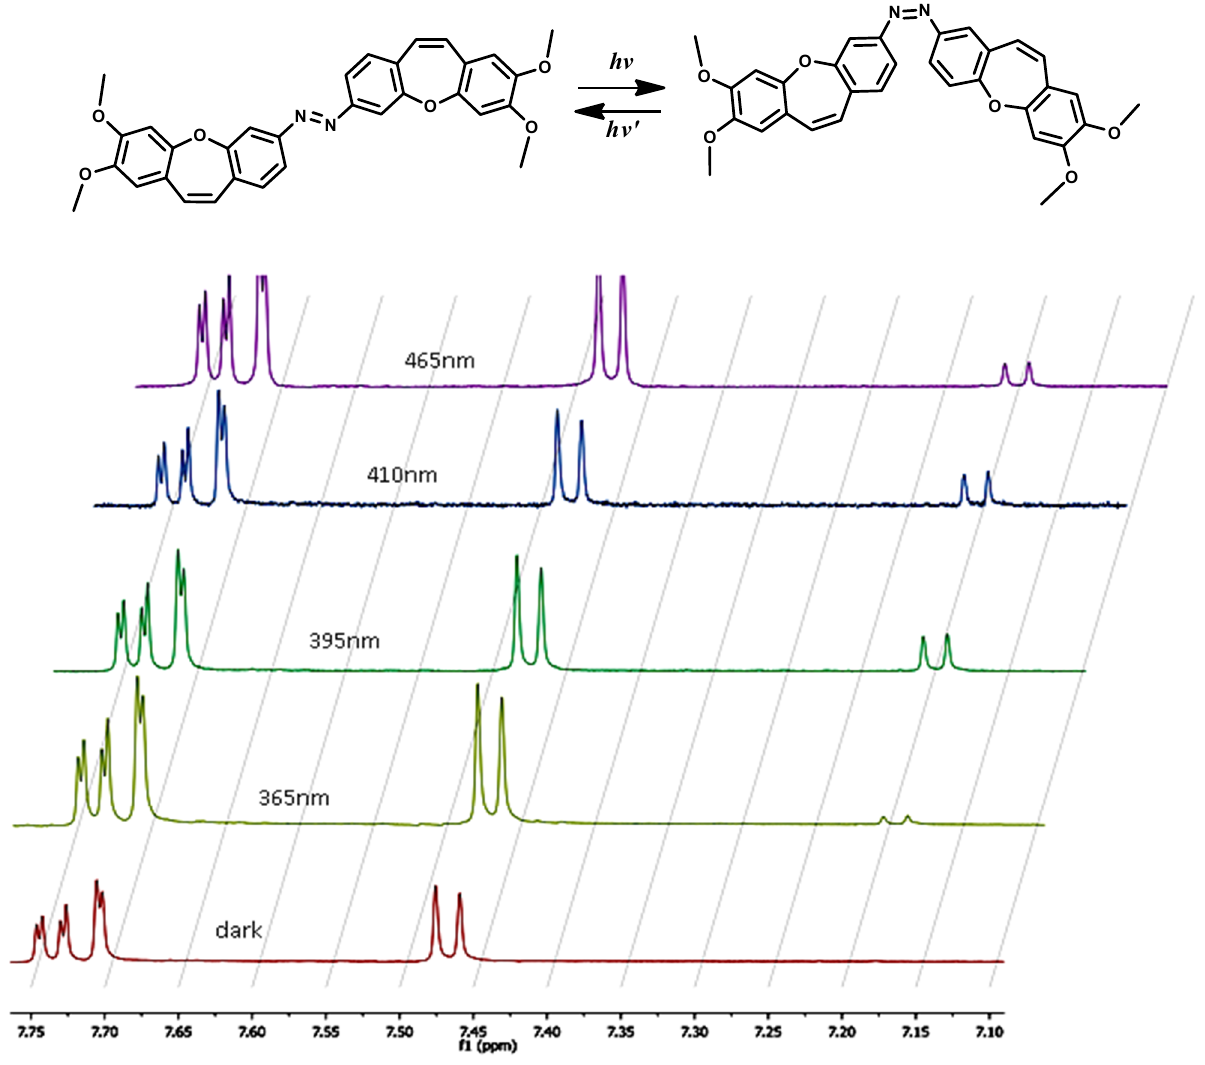
Figure 5. Photoisomerization of compound ( 2e ) measured by 1 H NMR. Aromatic 1 H NMR spectra in the dark-adapted state and at various PSSs measured under constant illumination at the indicated wavelengths.